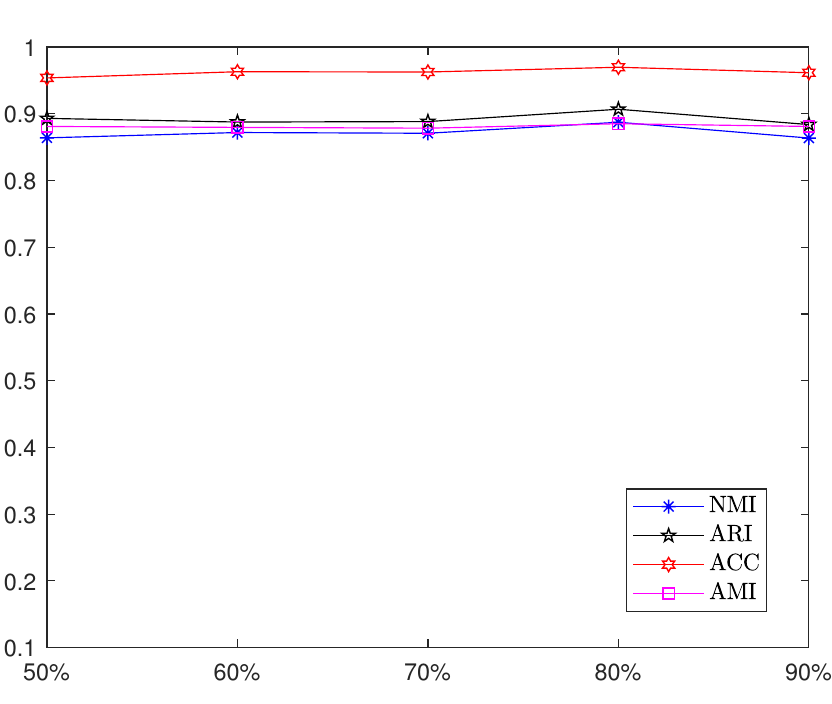
Figure 12. Results of Wdbc by 3WESP.